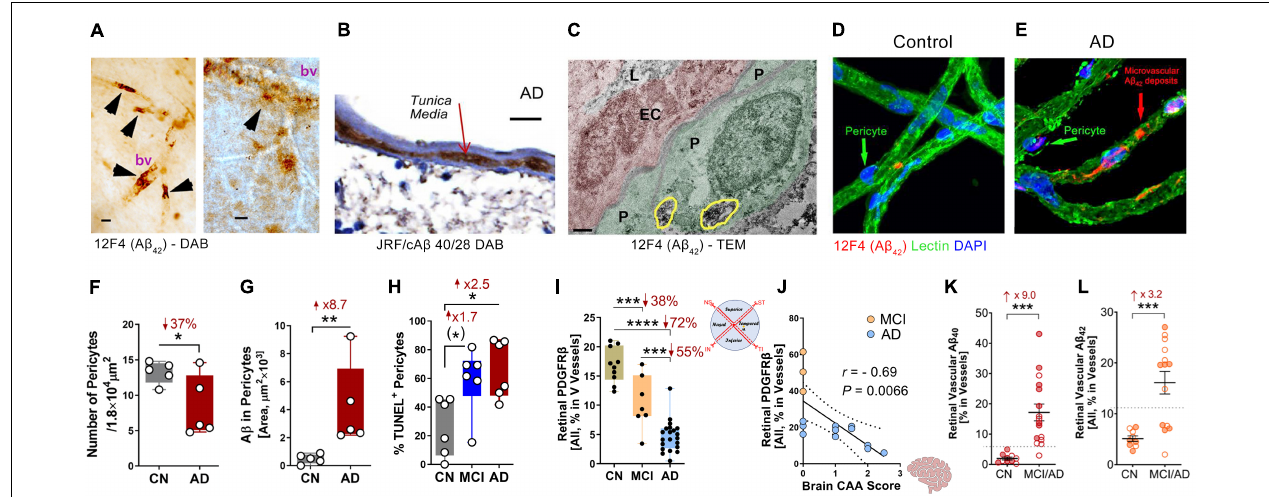
FIGURE 1 | Retinal vascular amyloidosis and pericyte loss in the retina of MCI and AD patients. (A) 3,3 (cid:48) -Diaminobenzidine (DAB) staining of A β 42 by 12F4 antibody in retinal blood vessels from flat-mount retina in an AD patient. Scale bar = 20 µ m. (B) DAB staining of A β 40 by JRF/cA β 40/28 antibody on a retinal cross-section sample from an AD patient. Scale bar = 20 µ m. (C) Transmission electron microscopy (TEM) for A β 42 by 12F4 antibody staining in retinal blood vessels and pericytes. P, pericyte; EC, endothelial cell; L, lumen. Yellow circles indicate A β 42 staining. Scale bar = 0.5 µ m. (D,E) Immunostaining of A β 42 by 12F4 antibody on retinal blood vessels isolated from an AD patient and control. Scale bars = 20 µ m. (F) Quantification of pericytes in AD patients and cognitively normal (CN) controls based on isolated blood vessels. (G) Stereological quantification of A β in pericytes in AD patients and CN controls based on isolated blood vessels. (H) Quantification of terminal deoxynucleotidyl transferase-mediated dUTP nick-end labeling (TUNEL) positive pericytes on retinal cross-sections from CN, mild cognitively impaired (MCI), and AD patients. (I) Stereological quantification of PDGFR β on retinal cross-sections from CN, MCI, and AD patients. (J) Pearson’s (r) correlation between cerebral amyloidosis angiopathy (CAA) and retinal PDGFR β from MCI and AD patients. (K,L) Stereological quantification of panel (K) . A β 40 and (L) A β 42 in CN versus MCI/AD patients. Filled circles represent males and clear circles represent females. Data from individual human donor as well as groups are shown as mean ± SEM. * p < 0.05, ** p < 0.01, *** p < 0.001, **** p < 0.0001, by one-way ANOVA with Sidak’s post hoc multiple comparison test (more than 2 groups) or unpaired 2-tailed Student’s t test (2 groups). Fold and percentage changes are shown in red. Panel A reproduced from Koronyo et al. (2017) with permission of ASCI via Copyright Clearance Center. Panels B–L reproduced from Shi et al. (2020b) under terms of the Creative Commons Attribution